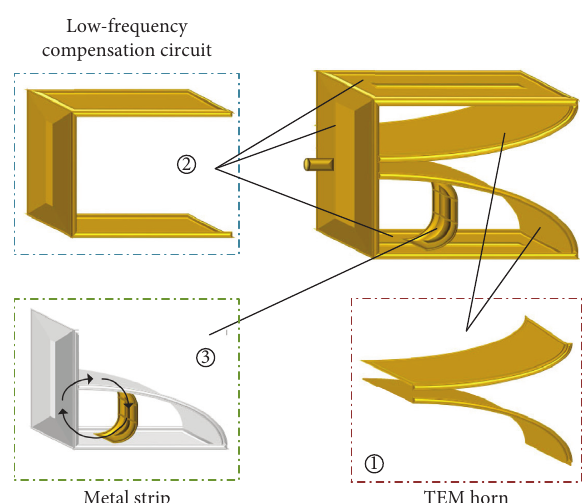
Figure 2: Structure of combined time-domain